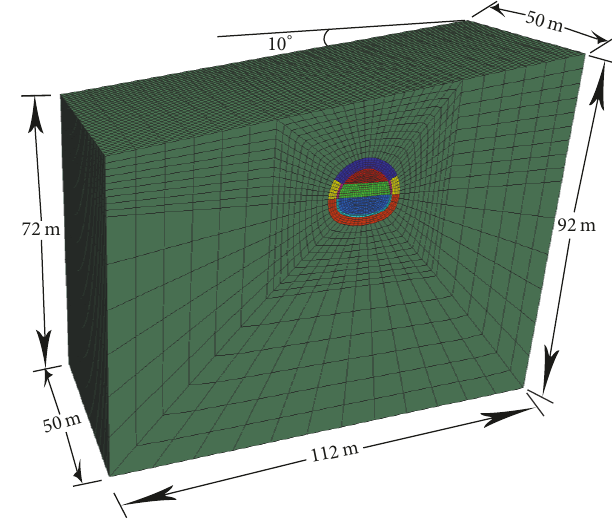
Figure 3: Numerical